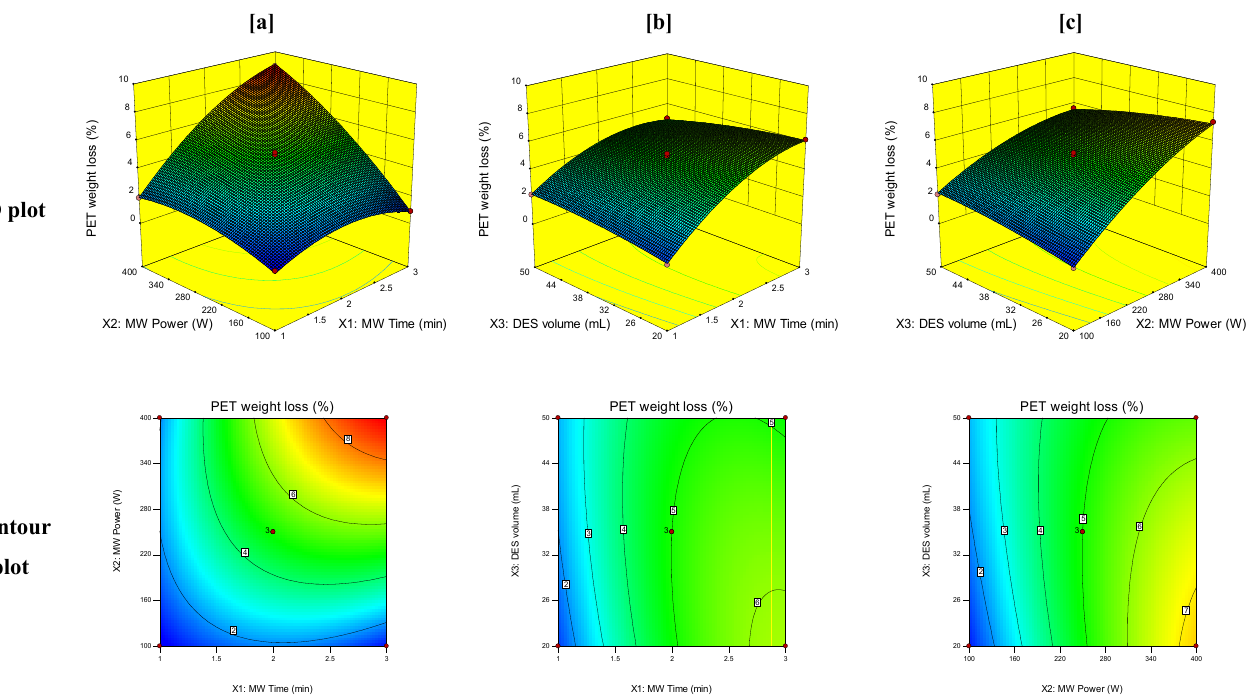
Figure 5. 3D and contour plots of the effect of the interaction of ( a ) MW time (X 1 ) and MW power (X 2 ), ( b ) MW time (X 1 ) and volume of DES (X 3 ), and ( c ) MW power (X 2 ) and volume of DES (X 3 ) on PET weight loss (%).